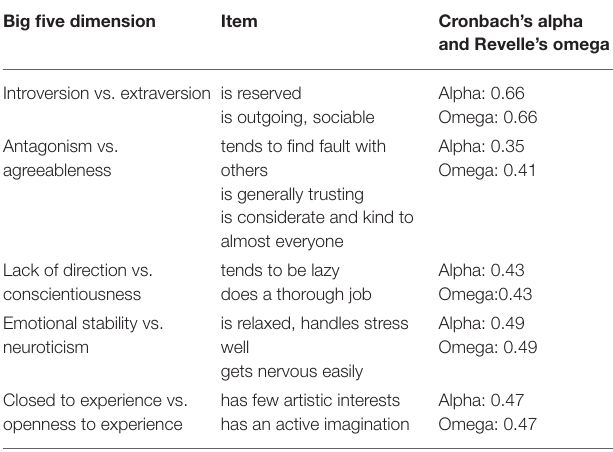
TABLE 3 | The Big Five Personality Dimensions and associated traits. Big five